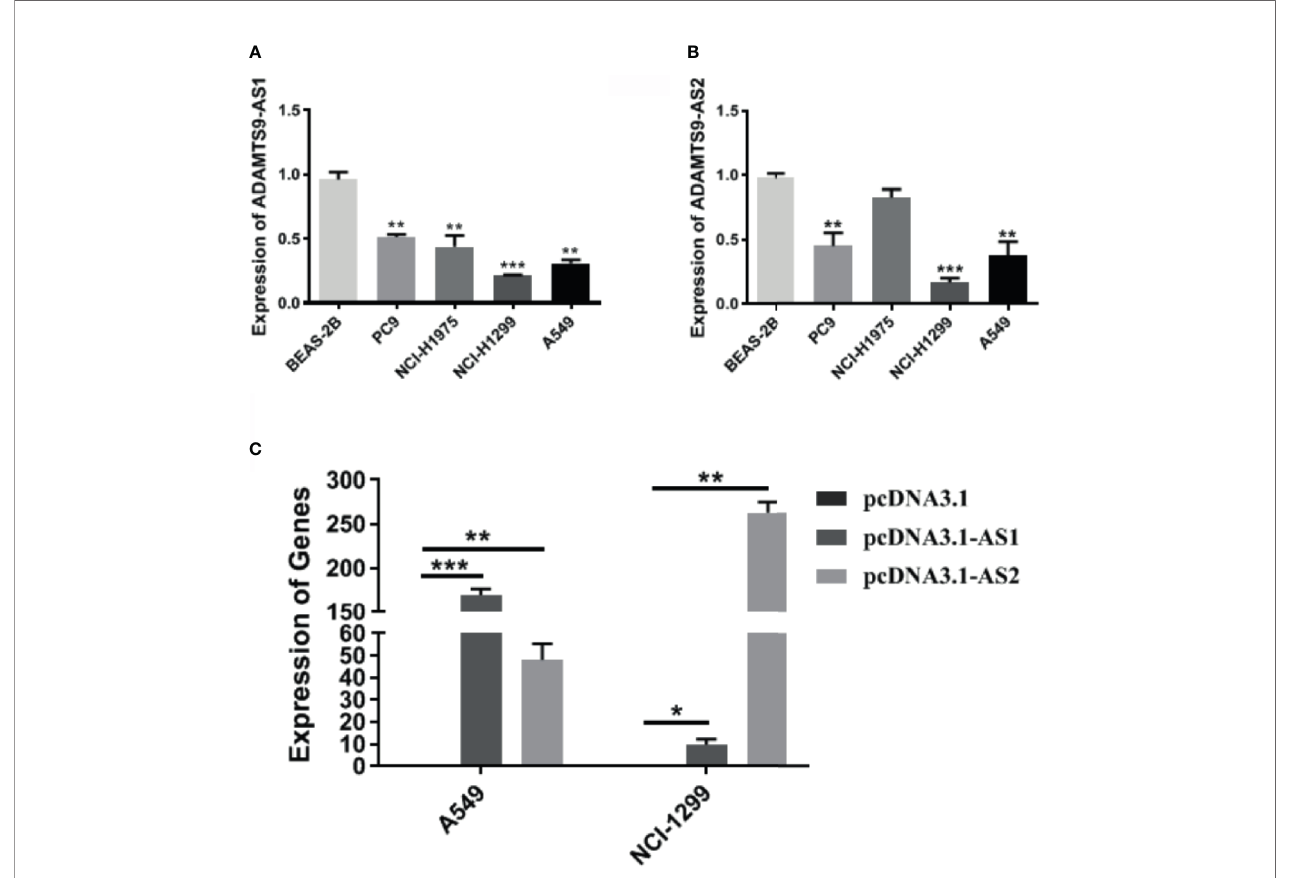
FIGURE 9 | The expression of ADAMTS9-AS1 and ADAMTS-AS2 in LUAD cells. (A) The expression level of ASAMTS9-AS1 in LUAD cell lines. (B) The expression level of ASAMTS9-AS2 in LUAD cell lines. (C) The transfection ef fi ciency of cells transfected with pcDNA3.1-AS1 or pcDNA3.1-AS2. *p < 0.05; **p < 0.01; ***p < 0.001. LUAD, lung